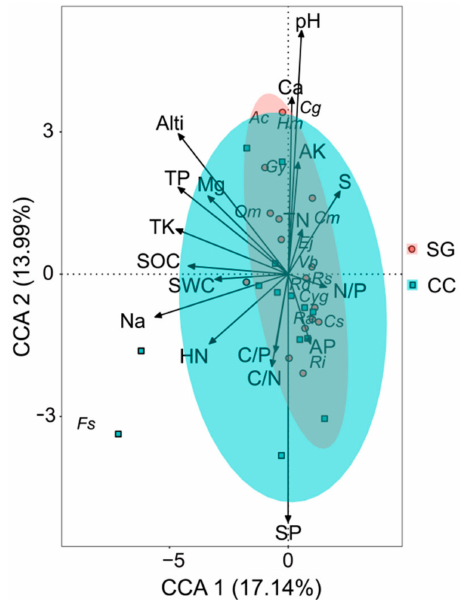
Figure 7. Ordination of the main plant species and soil topography gradient variables of the small gap and closed canopy in the canonical correspondence analysis (CCA). Log10 (number of individuals + 1) wasusedtotransformplantspeciesdata. SG:smallgaps( n = 15), CC:closedcanopy( n = 14). Significantly di ff erent at p ≤ 0.001 and p ≤ 0.05. Alti: altitude, S: slope, SP: slope position. Cyg-Cyclobalanopsis glauca